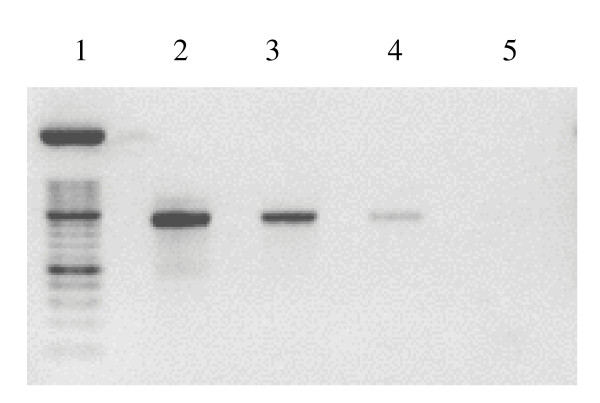
Defining the detection limit of the PCR system. Decreasing amounts of purified E. sakazakii strain ATCC 51329 genomic DNA target (100 ng – 1 pg) were amplified by PCR. Lane 1, DNA 100 bp marker; In lanes 2 to 5, 1 ng, 100 pg, 10 pg, 1 pg of E. sakazakii DNA was used per reaction.